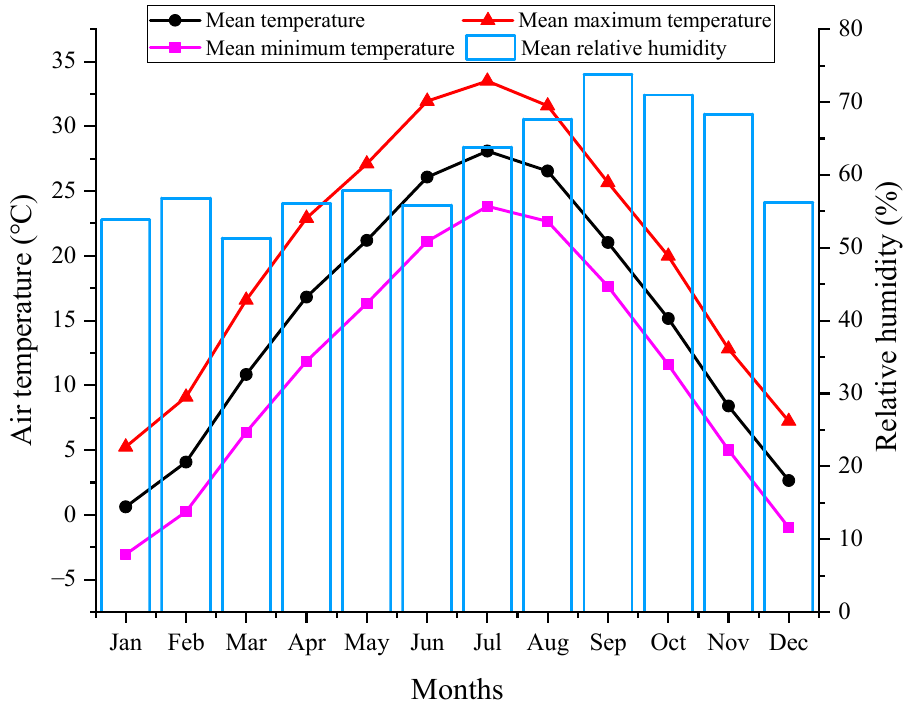
Figure 1. The monthly variation of temperature and relative humidity in Xi’an (2010–2019)